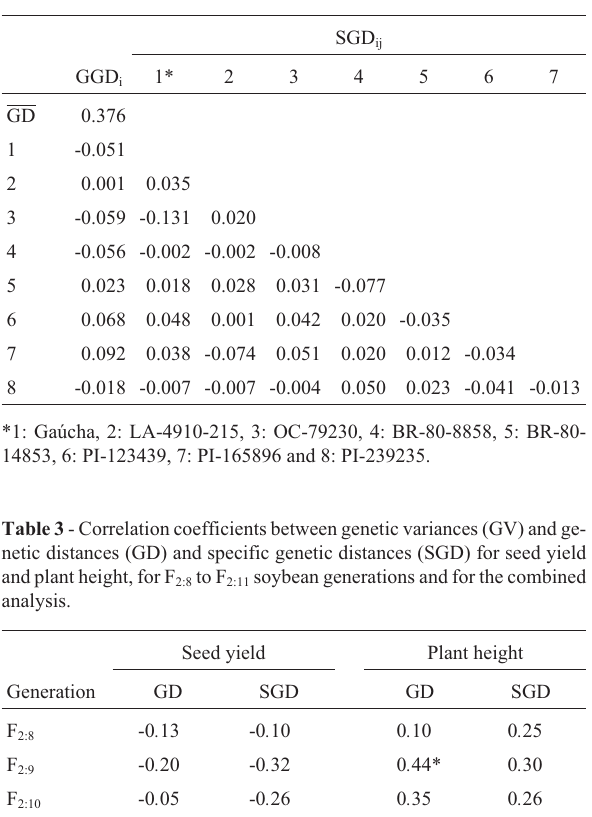
Table 1 - Genetic distances (GD) between soybean lines. Table 2 - Mean component (GD), general genetic distance (GGD i ) for each line and specific genetic distance (SGD ij ) between lines.